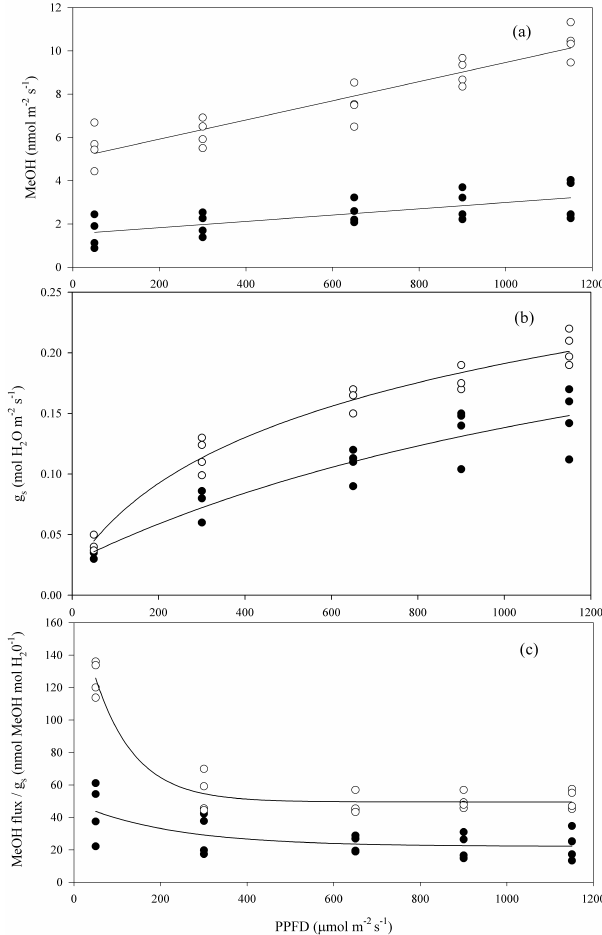
Fig. 1. (a) MeOH emission, (b) stomatal conductance ( g s ) , and (c) MeOH emission normalized for g s from mature ( n = 4; black circles) and immature ( n = 4; open circles) L. esculentum over five light levels at constant temperature (29 ± 1 ◦ C). MeOH emission (slope = 0.0015, t = 4 . 09, P = 0 . 001 for mature; slope = 0.0044, t = 10 . 52, P < 0 . 0001 for immature) and g s ( F = 112 . 94 P < 0 . 0001 R 2 = 0 . 86 for mature; F = 19 . 06 P = 0 . 004 R 2 = 0 . 96 for immature) significantly increased with PPFD. Normalized MeOH emissions were negatively associated with PPFD (regression coef- ficient =− 0.0006, z = − 5 . 53, P < 0 . 0001 for mature; regression coefficient =− 0.0008, z =− 50 . 20, P < 0 . 0001 for immature).